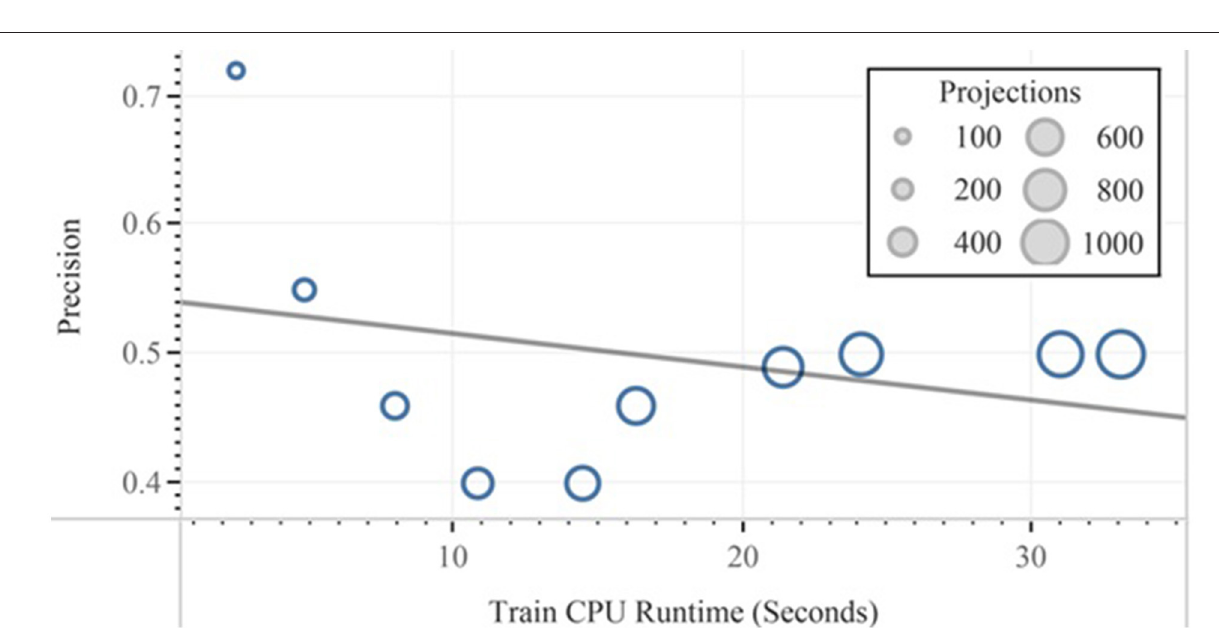
Frontiers in Public Health |